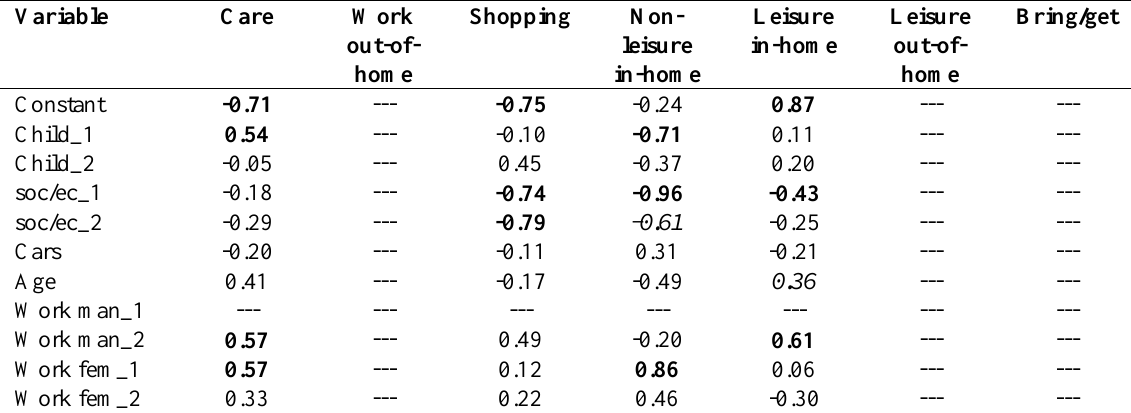
Table 5. Effects of the independent variables on the time spent together Variable Care